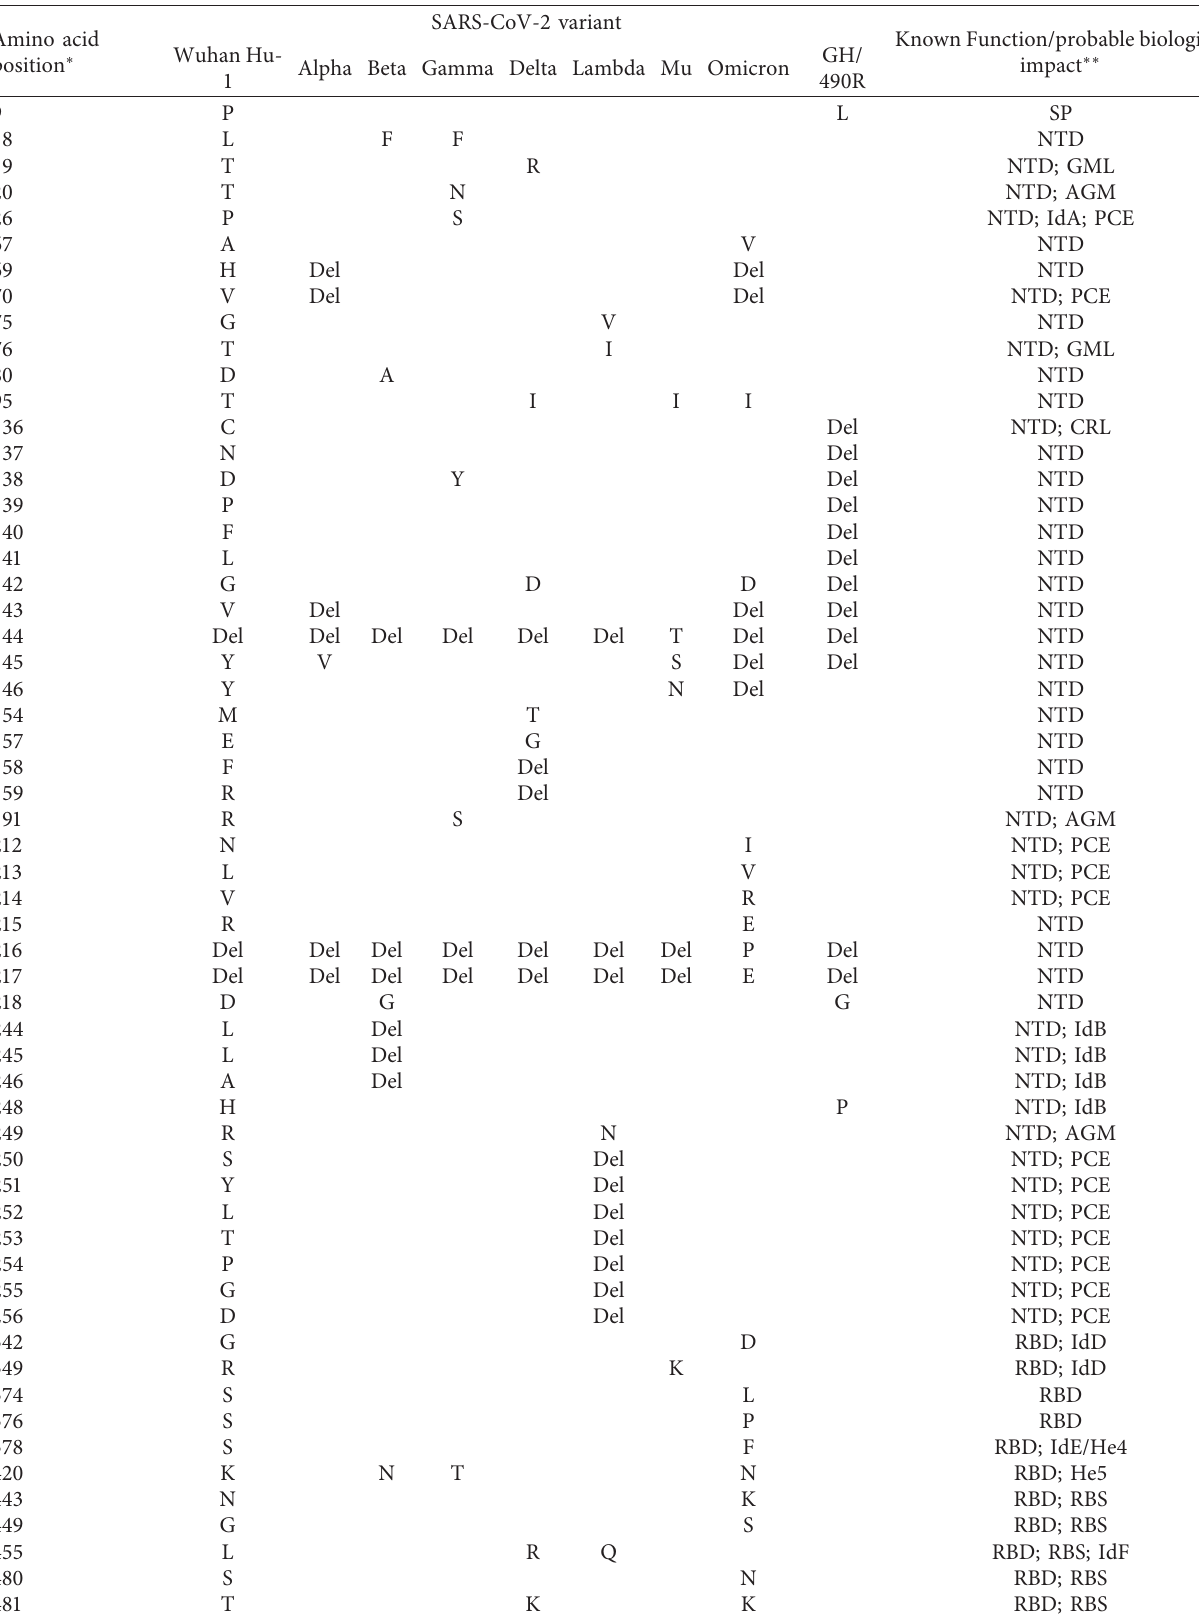
Table 1: Polymorphic amino acids residues of spike protein of SARS-CoV-2 Wuhan Hu-1 and all variants with possible biological function. Amino